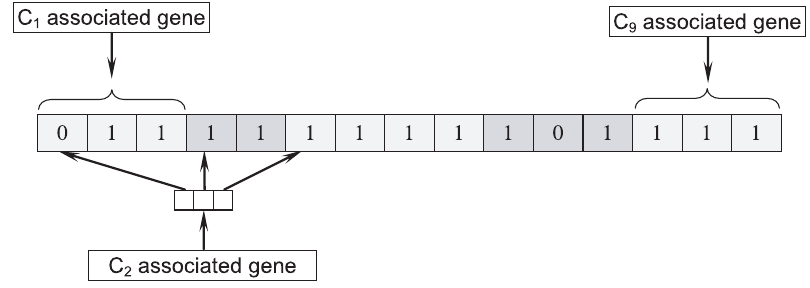
Fig. 4. Chromosome storage.